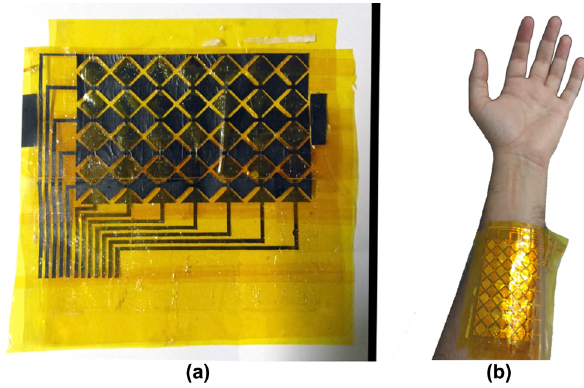
Figure 5: The layers are positioned to form the matrix ( a ) , resulting in a fl exible sensor that can be placed in any surface, for example, an arm ( b